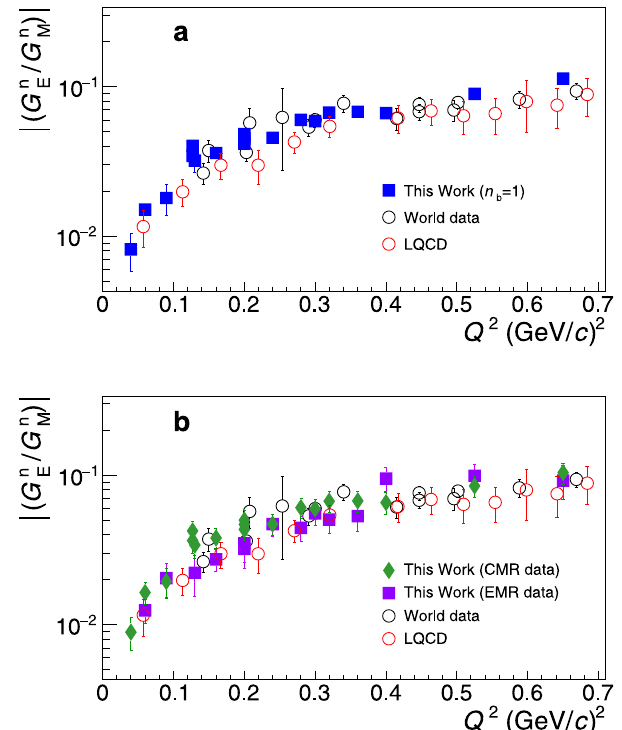
Fig. 1 The elastic neutron form factor ratio. a The neutron electric to = G n magnetic form factor ratio G n : world data 7 – 21 (black open circles), E M ratios calculated from the N → Δ measurements 24 – 32 through Eq. (1) for n = 1 ( fi lled-squares), and lattice Quantum Chromodynamics (LQCD) b = G n results (red open circles) 33 . b The G n results from the large- N c analysis E M of the Coulomb quadrupole measurements (CMR, fi lled diamonds) and of the Electric quadrupole measurements (EMR, fi lled boxes) from the experiments 24 – 32 . The neutron world data (black open circles) and the LQCD results (red open circles) 33 are the same as in panel ( a ). The error bars correspond to the total uncertainty, at the 1 σ or 68% con fi dence